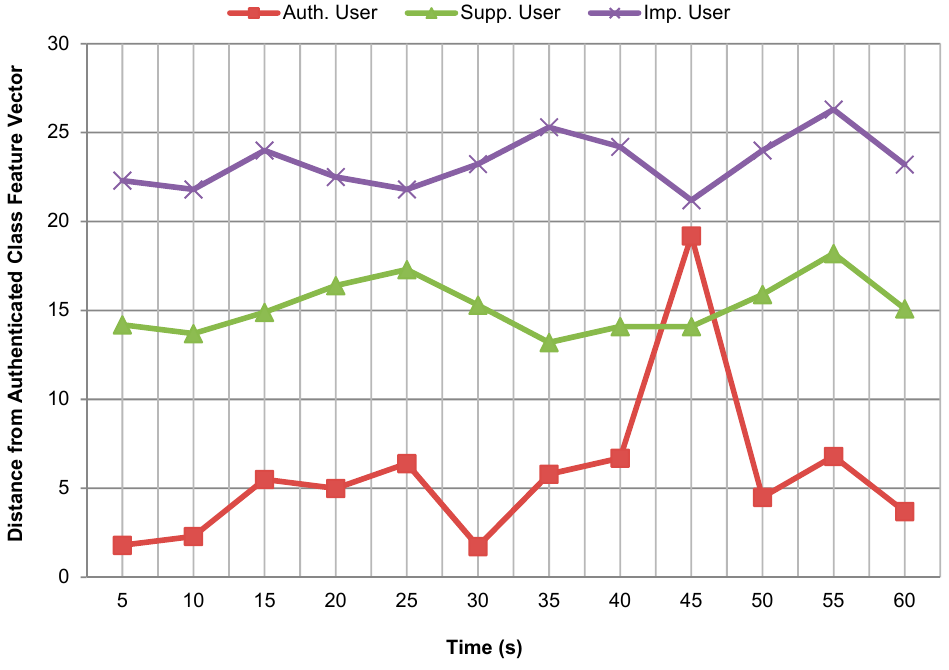
Figure 7. Euclidean distance between the authenticated user class feature vector and the feature vectors computed from testing data for different candidate users.